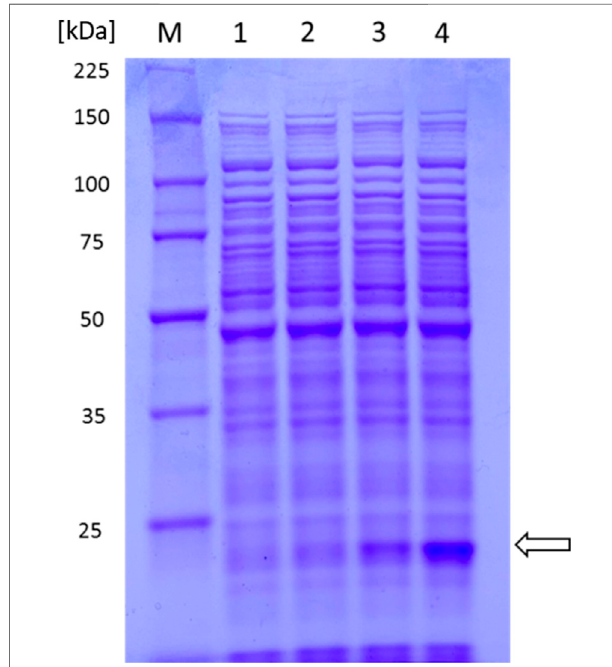
FIGURE 4 | SDS-PAGE of C. glutamicum MA225 crude extracts carrying different vectors for expression analysis of the comt gene. 1. MA225; 2. MA225 with pYL230; 3. MA225 with pYL200; and 4. MA225 with